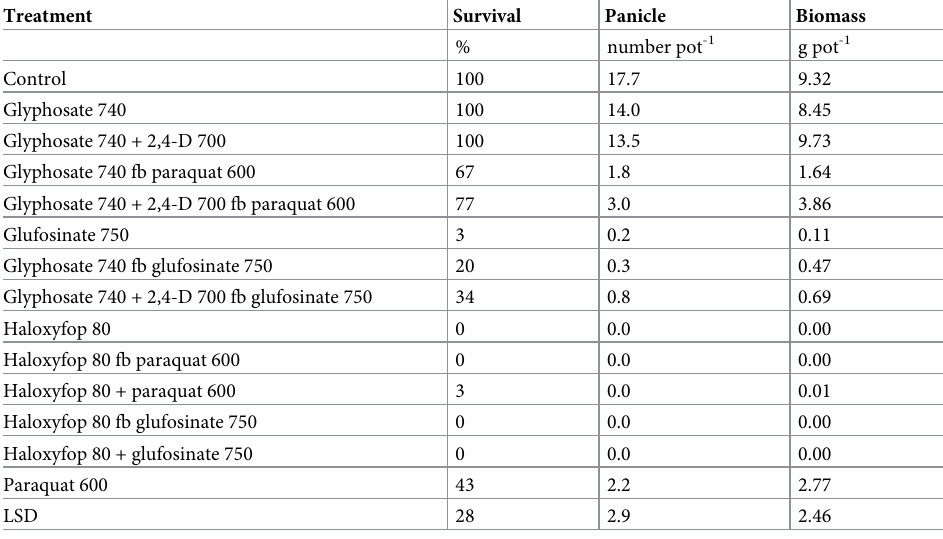
Table 2. Effect of herbicide mixtures and sequential herbicides on survival, panicle production, and shoot biomass of glyphosate-resistant Chloris virgata . Herbicides were sprayed at the 8–10 leaf stage. Treatment